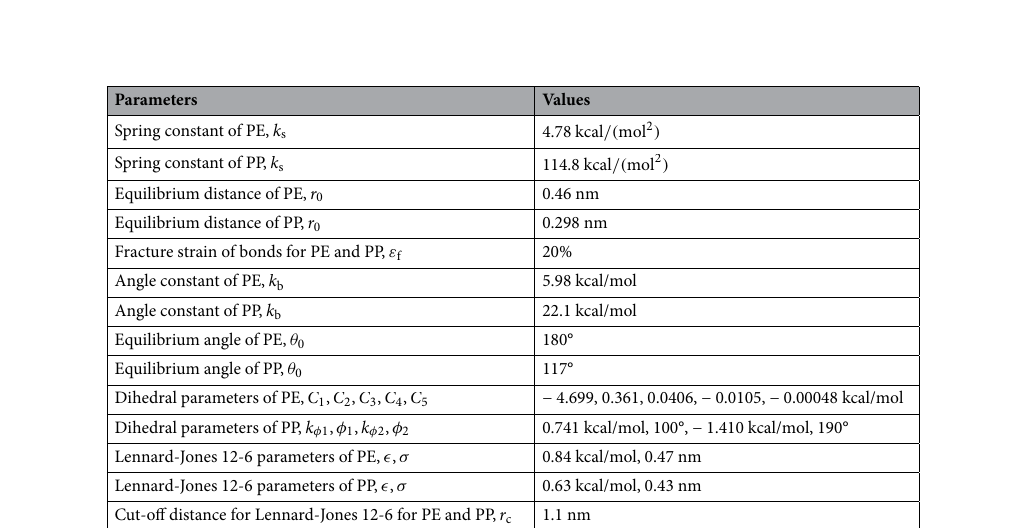
� is the component normal to ⊥